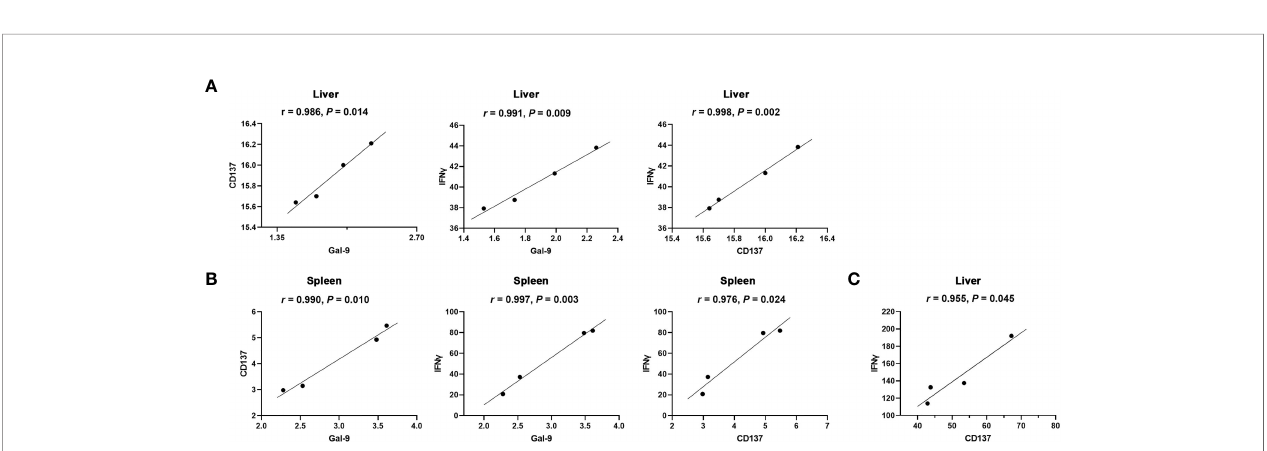
FIGURE 6 | The mRNA expression levels of Th1 and Th2 cytokines in the livers (A) and spleens (B) of mice from different groups on day 7 p.i. Values are means from triplicate measurements, and data are presented as means ± SD; two independent experiments were performed with four mice per group. * P < 0.05, ** P < 0.01, and *** P < 0.001. Y axis represents the mRNA relative expression level (REL) of different genes.